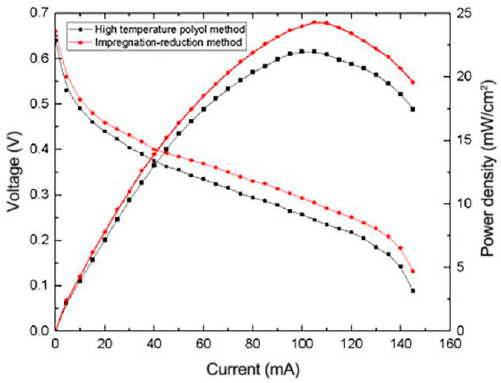
Figure 7. Effects of different preparation methods on the performance of μ DMFC.